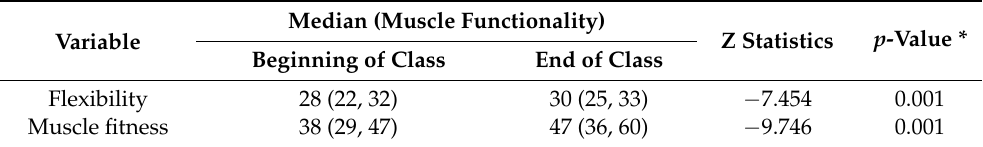
Z Statistics p -Value *